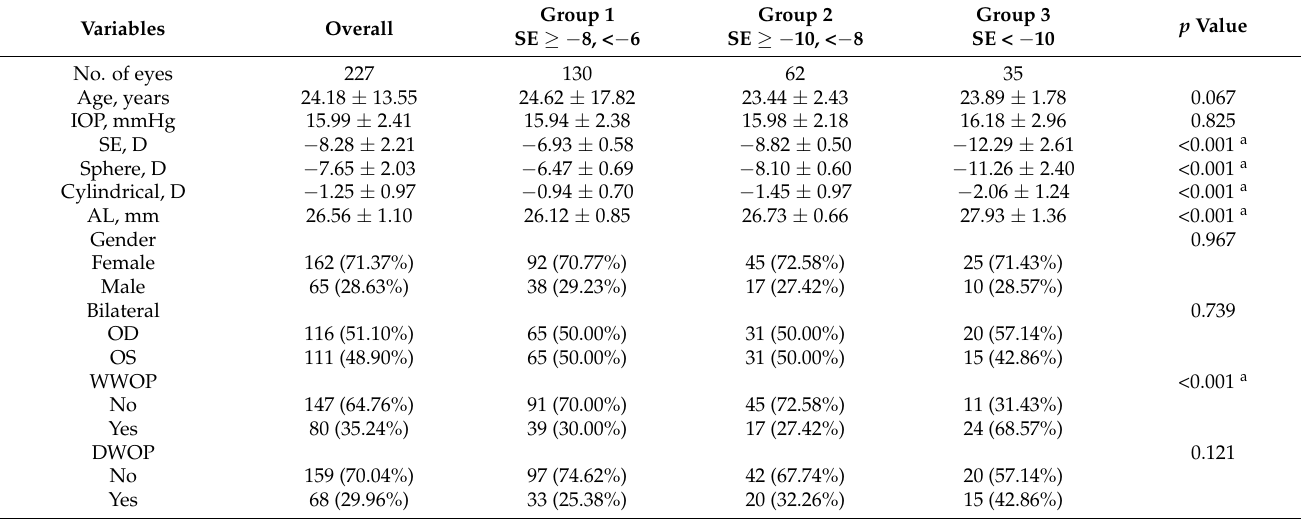
Table 1. Characteristics and comparison of participants in different groups.